Question: What type of chart is this?
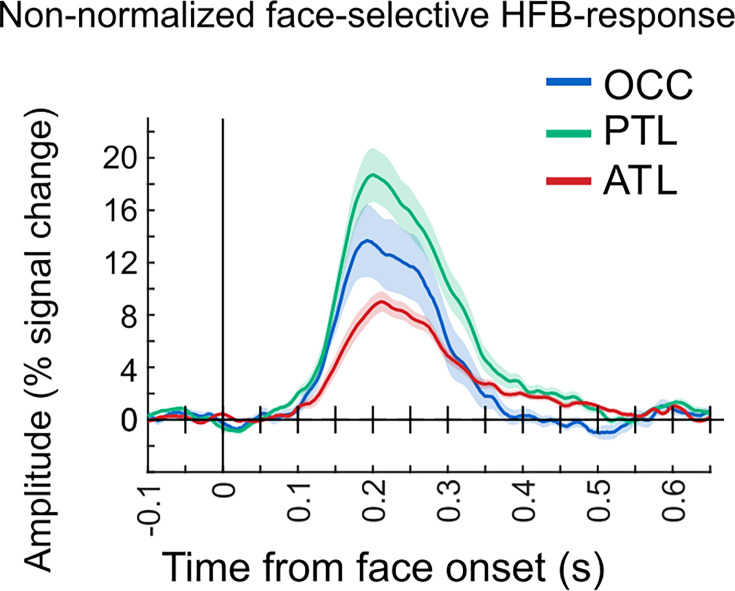
Answer: bar